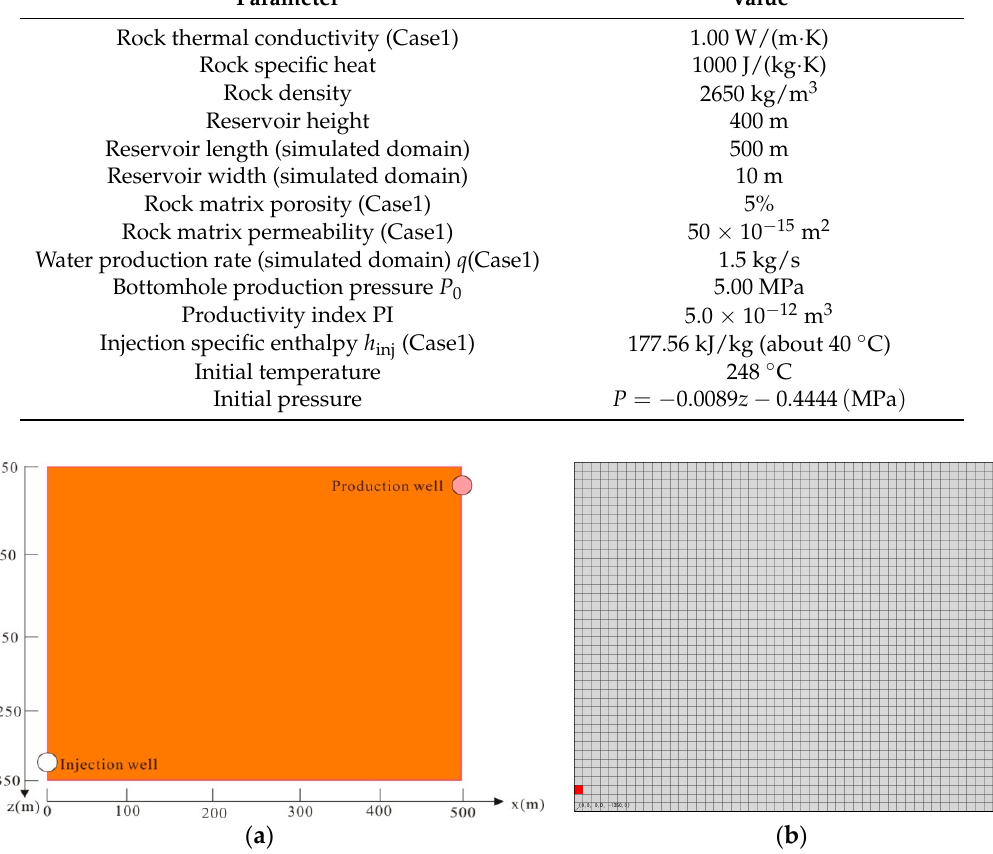
Figure 3. A schematic of ( a ) the fractured reservoir at well ZK4001 and ( b ) the corresponding grid.